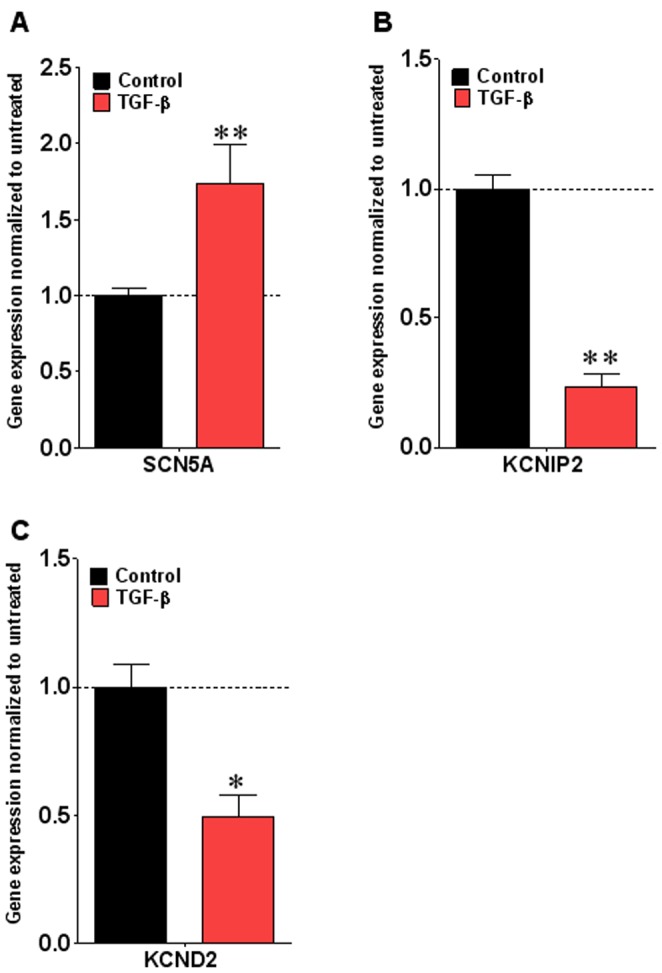
Effects of TGF-β1 on mRNA expression after 72 hr treatment with TGF-β1 (1 ng/ml).Real time PCR was performed using Taqman Primers. GAPDH was used as an internal control. A) Changes in SNC5A gene expression, B) changes in KCNIP2 gene expression and C) changes in KCND2 gene expression. Values are mean ± standard error of the mean, N = 6 in each group. *indicates p<0.05, **indicates p<0.01 significant difference between control and TGF-β1 treated cells by two-way ANOVA with Bonferroni post-test.